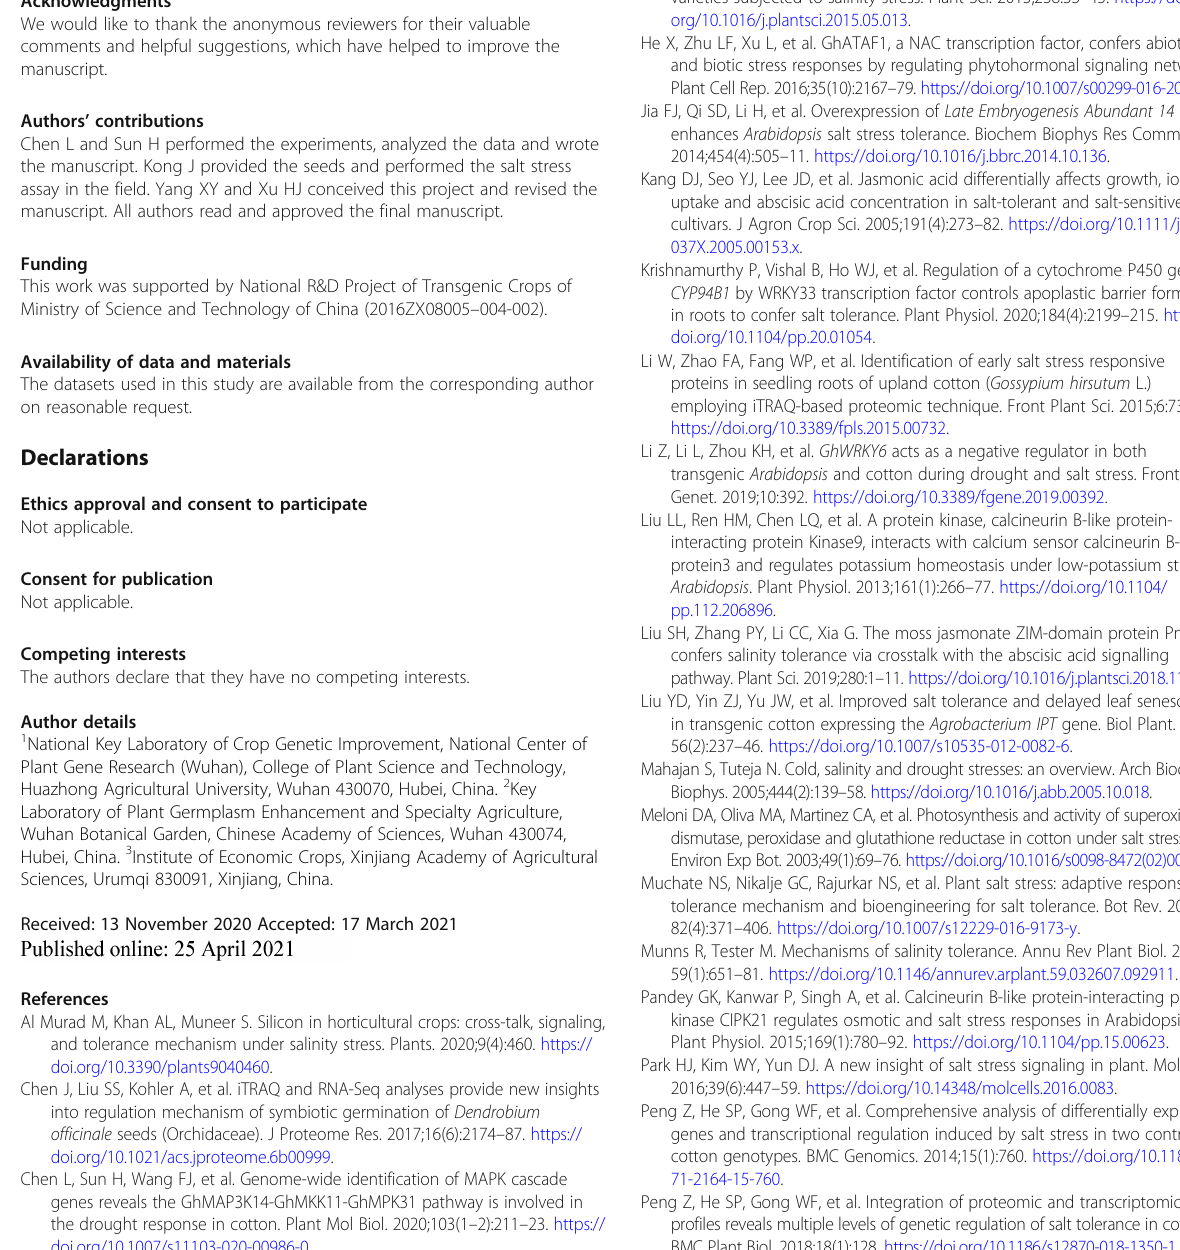
changes of key node genes involved in different hormone signal path- way under salt stress treatment. Figure S7. Transcription factors response to salt stress in cotton. a and b stand for the statistics of up-regulated and down-regulated transcription factors induced by salt stress, respect- ively. c The expression patterns of different transcription factors under salt stress treatment. Figure S8 . Potential protein interaction models through the STRING database. a Predicted CBL-CIPK protein interaction patterns. b Predicted MAPK signal cascade protein interaction patterns. Table S1. Primers used for qRT-PCR. Table S2. Transcriptome data statistics. Table S3. Statistics on the correlation between DEGs and DEPs. Table S4. Infor- mation of associated